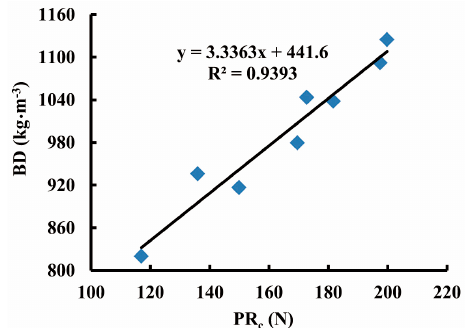
Figure 9. The converting equation between the PR c corrected from penetration resistance (PR) and silage fresh bulk density (BD)